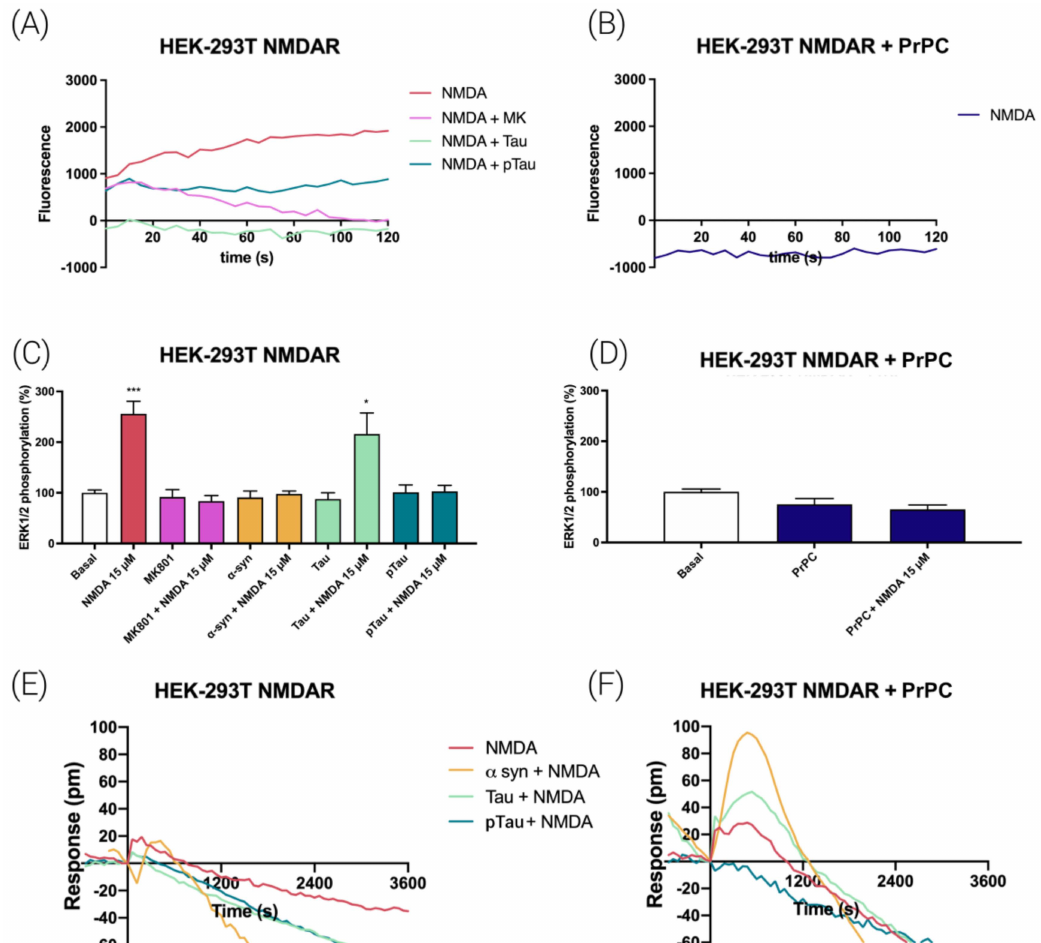
Figure 5. Signaling in HEK-293T cells expressing NMDAR-PrPC complexes. HEK-293T cells were transfected with the cDNAs for two protomers of the NMDA receptor: GluN1 (1 µ g) and GluN2B (0.75 µ g) and/or with the cDNA for the human PrNP (1 µ g) ( B , D , F ). Cells were treated NMDA (15 µ M) and, when indicated, with the selective receptor antagonist, MK-801 (1 µ M). Treatments with alpha-synuclein (4 µ M), Tau (1 µ M) or pTau (1 µ M) proteins were performed for 2 h prior to NMDA addition. For calcium mobilization assays, HEK-293T cells were also transfected with the cDNA for the engineered calcium sensor, 6GCaMP (1 µ g). Real-time calcium-induced fluorescence was collected for 120 s ( A , B ). ERK1/2 phosphorylation was analyzed using an AlphaScreen ® SureFire ® kit (Perkin Elmer) ( C , D ). Values are the mean ± S.E.M. of 5 independent experiments performed in triplicate. One-way ANOVA followed by Bonferroni’s multiple comparison post hoc test was used for statistical analysis (* p < 0.05, *** p < 0.001 versus basal condition). ANOVA summary: ( C )